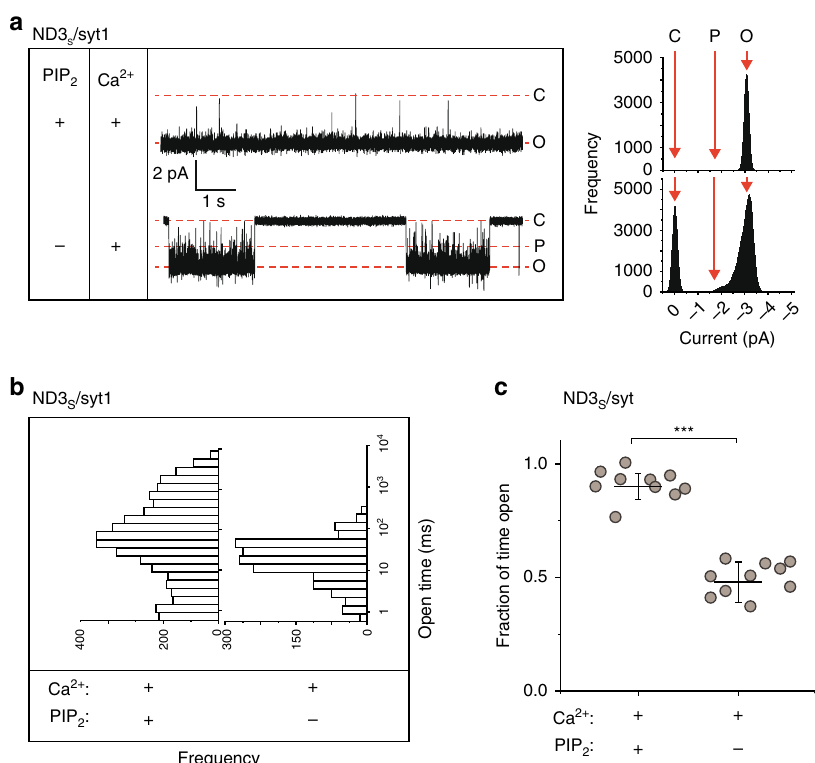
Fig. 3 Syt1 (cid:129) PIP 2 interactions stabilize the open state of fusion pores. a Traces of single pores, formed using ND3 S /syt1 plus Ca 2 + , with ( + , upper panel) and without ( − , lower panel) 2% PIP 2 in the BLM. Respective current histograms are shown beside the traces. Closed (C), open (O), and partially open (P) states are shown; the current and time scale applies to both traces. b Open dwell time histogram of pores (combined data from all trials), under the conditions described in a . c Fraction of time pores were open over a 30-min period, calculated from the data collected under the indicated conditions. Error bars indicate SEM from ten independent BLMs and three independent sets of each kind of ND; the Student ’ s T test was performed to compare the two means; *** p <